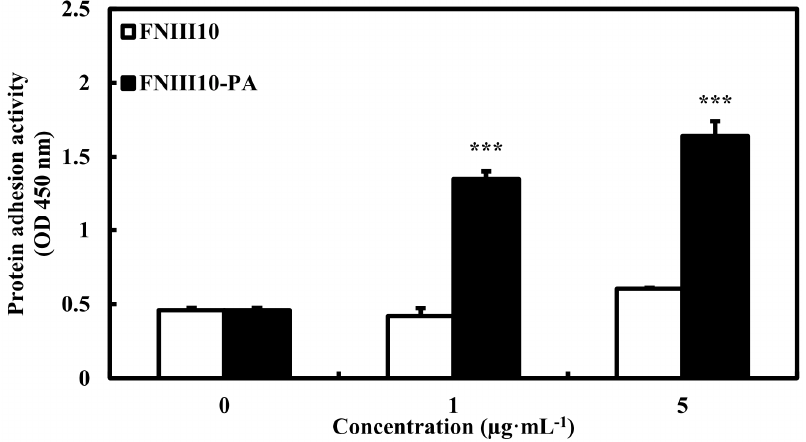
Figure 2. Protein adhesion activity of FNIII10-PA on PCL fiber. PCL fibers were placed in 24-well plates and coated with 0, 1, or 5 μ g·mL − 1 of FNIII10 or FNIII10-PA overnight at 4 °C. Protein adhesion activities are expressed as means ± SD ( n = 3). *** p < 0.001. OD = optical density.